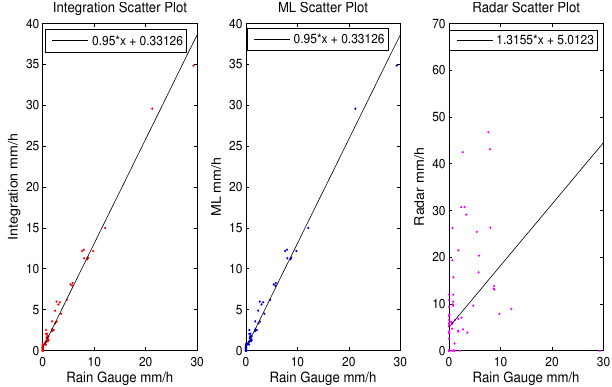
Figure 14. Rain rate scatter plots of the integration (left), ML (mid- Fig. 14. Rain rates scatter plots of the Integration (left), the ML (middle) and the radar (right) with respect to dle) and radar (right) with respect to the rain gauge at the Ramle site theraingaugeinRamlesiteforevent(1). for event 1.